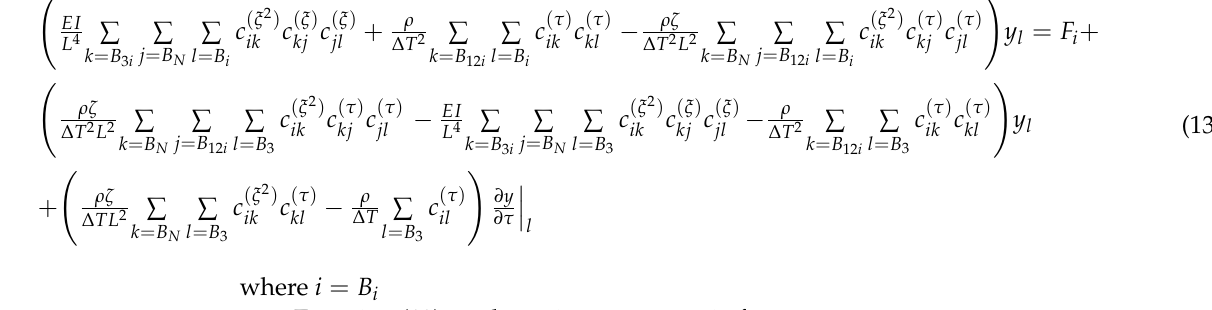
Figure 3. Allocation of grid node regions. The gradual calculation method needs to extract the initial conditions (displacement and velocity) of each time step. At the same time, in order to substitute the boundary conditions, the discrete control Equation (9) needs to be reconstructed. Each partial deriv- ative term in Equation (9) is decomposed as follows: